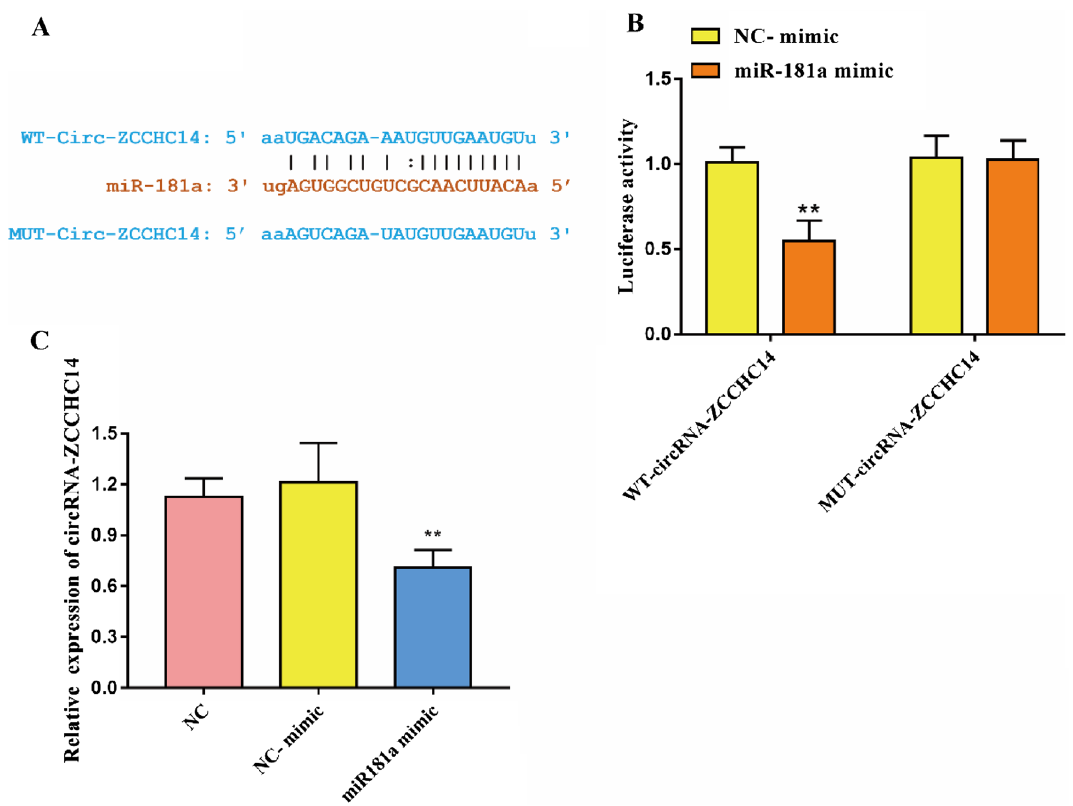
Figure 3. circRNA-ZCCHC14 targets miR-181a ( A ) circRNA-ZCCHC14 and miR-181a binding sequence; ( B ) Dual-luciferase reporter system to verify the binding of circRNA-ZCCHC14 and miR-181a; ( C ) RT ‒ qPCR detection of the expression level of